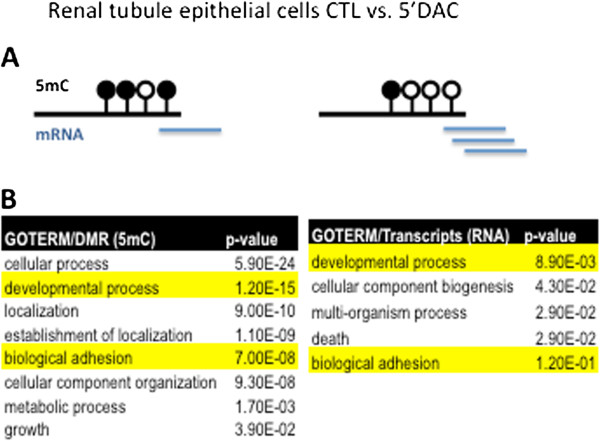
Regulation of transcripts by a DNA methyltransferase inhibitor in in vitro cultured human tubular epithelial cells. Gene ontology terms of transcripts showing differential expression in the decitabine-treated cells. (A) Illustration of regions that showed differential methylation of cultured HKC8 cells treated with 0.5 μM decitabine (5'DAC). CTL, control. (B) The interconnected network analysis highlighted the differential expression of cell adhesion and developmental pathways. These genes are also differentially expressed and methylated in the original CKD dataset. GO, gene ontology.